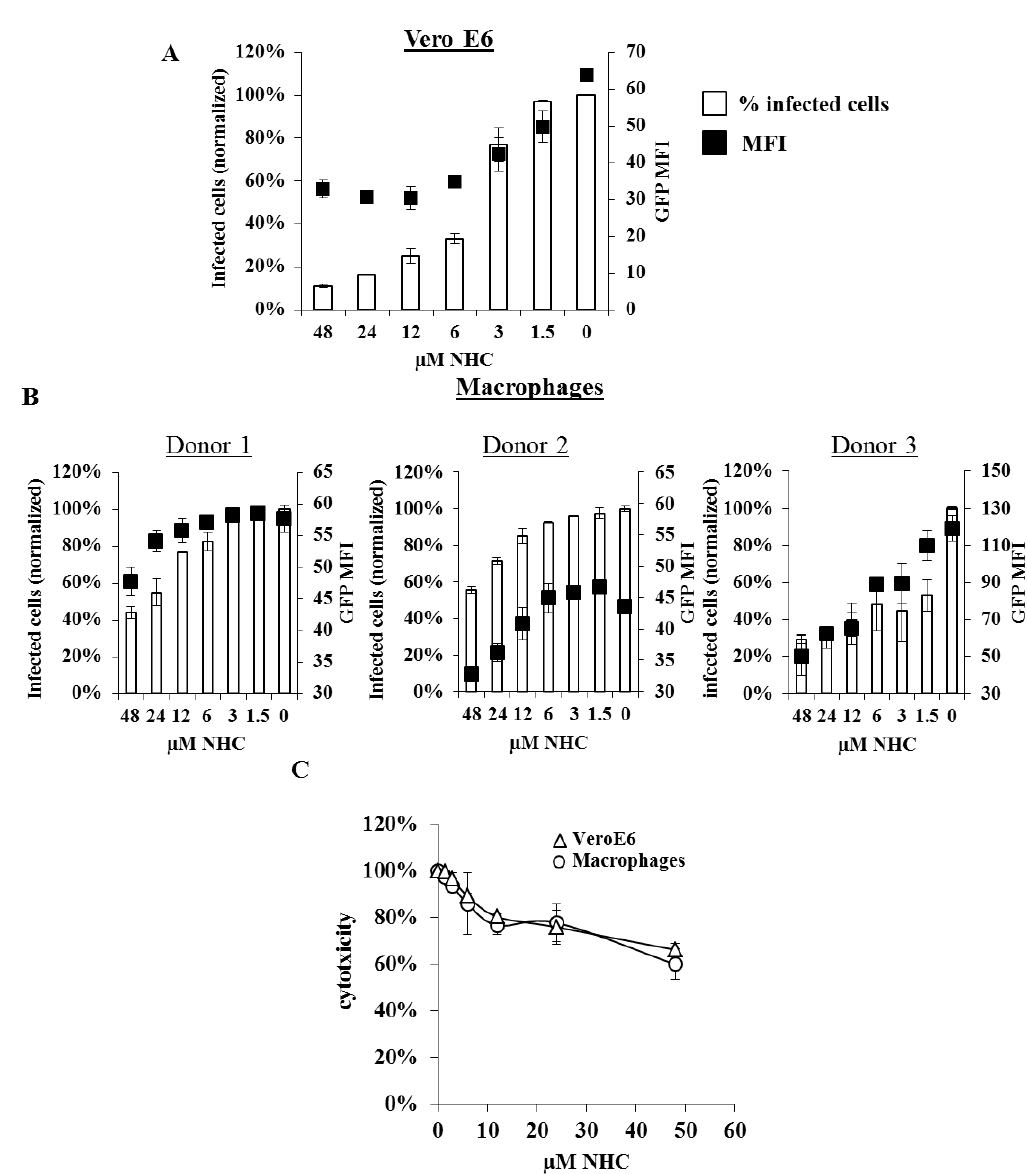
Figure 2. Dose-response assessment and β -D-N4-hydroxycytidine (NHC) cytotoxicity Vero E6 cells ( A ) and monocyte-derived macrophages ( B ) were infected with EBOV/GFP at an MOI of 0.1, and maintained in the presence of NHC at the indicated concentrations. The cells were analyzed forty-eight hours post infection as described in Figure 1. Macrophages were differentiated upon incubation of monocytes (three different donors) with 100 ng/mL of M-CSF (EuroBio, Courtaboeuf, France). The graph displays both the percentage of infected cells and the GFP MFI as measured by flow cytometry (Beckman Coulter, Gallios, Brea, CA, USA); ( C ) MTT (3-(4,5-dimethylthiazol-2-yl)-2,5-diphenyltetrazolium bromide) cytotoxicity assay. Vero E6 cells and monocyte-derived macrophages were maintained in the NHC presence for 48 h prior to addition of MTT (5 µg/mL, Sigma Aldrich, Saint-Quentin Fallavier, France) followed by 3 h incubation and optical density analysis The graph displays the OD value normalized to the 100% cytotoxicity control.